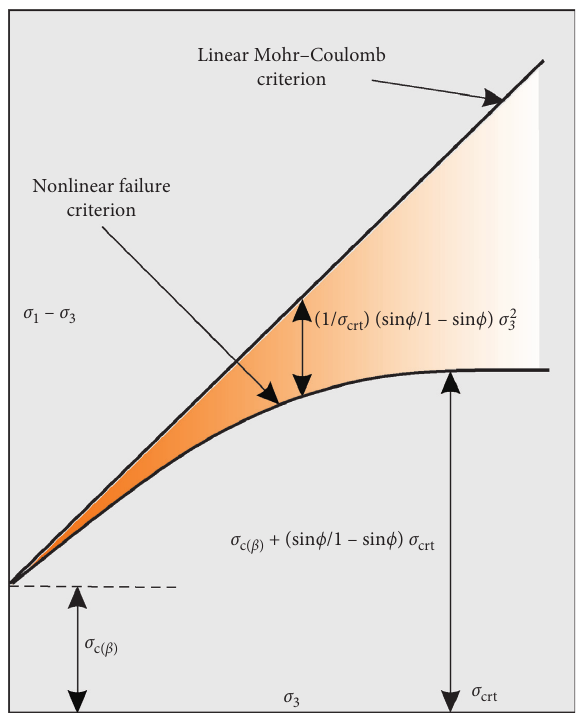
Figure 4: Nonlinear failure criterion proposed by Singh et al.